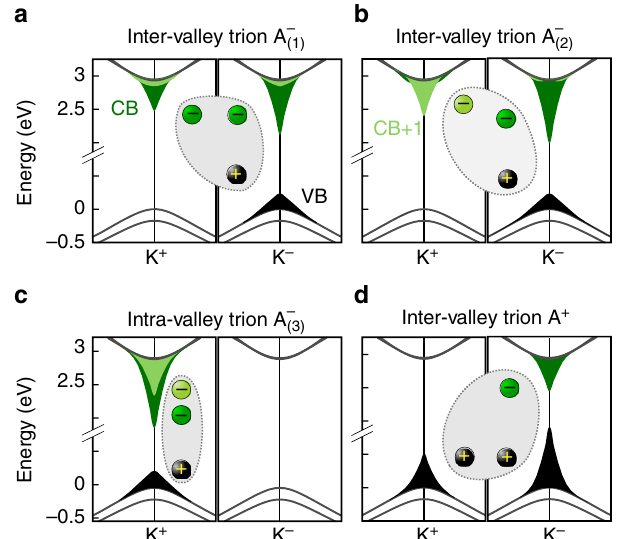
Fig. 2 Quasiparticle band structure of an MoS 2 monolayer. The fi gure focuses on the vicinity of the K + and K − points. a – c For all three negative trion excitations A (cid:1) ð the band-resolved k -dependent contributions 1 ; 2 ; 3 Þ (square of the wave functions) are attached to the respective bands (black for the VB and dark (light) green for the CB (CB+1)). For the A (cid:1) ð trions the 1 ; 2 Þ electrons are located in different valleys, while for A (cid:1) ð only one valley 3 Þ contributes. The initial one-electron state resides at K + in the CB.